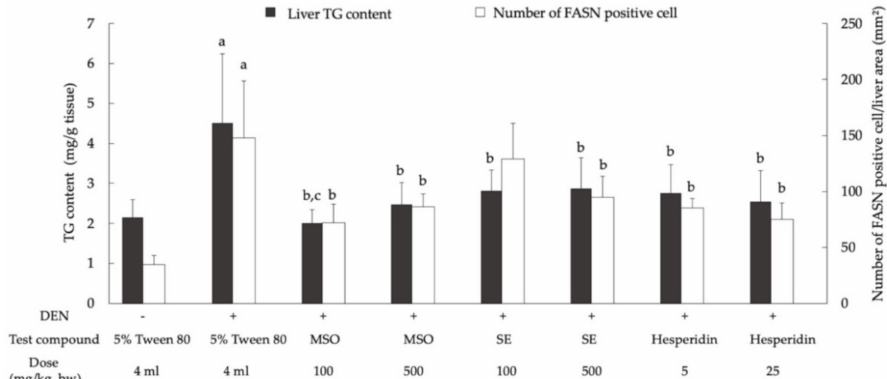
Figure 7. Effect of a 10-week administration of MSO and its compositions on hepatic lipogenesis in the livers of rat. Values are expressed as mean ± SD. DEN: diethylnitrosamine; FASN: fatty acid synthase; MSO: mixed sesame and orange seed extract; SE: sesame extract; TG: triglyceride; a significantly different from a negative control group ( p < 0.05); b significantly different from a positive control group ( p < 0.05); c significantly different from group 4 (SE 100) and group 6 (Hesperidin 5) ( p <